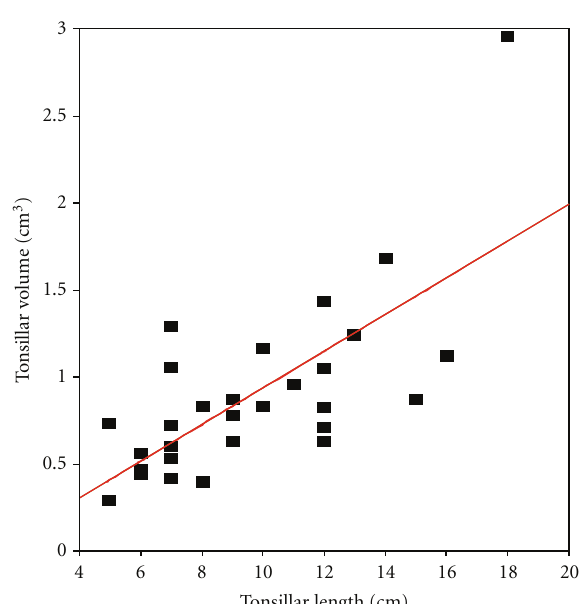
Figure 3: The figure shows the correlation between the herniated tonsillar length and